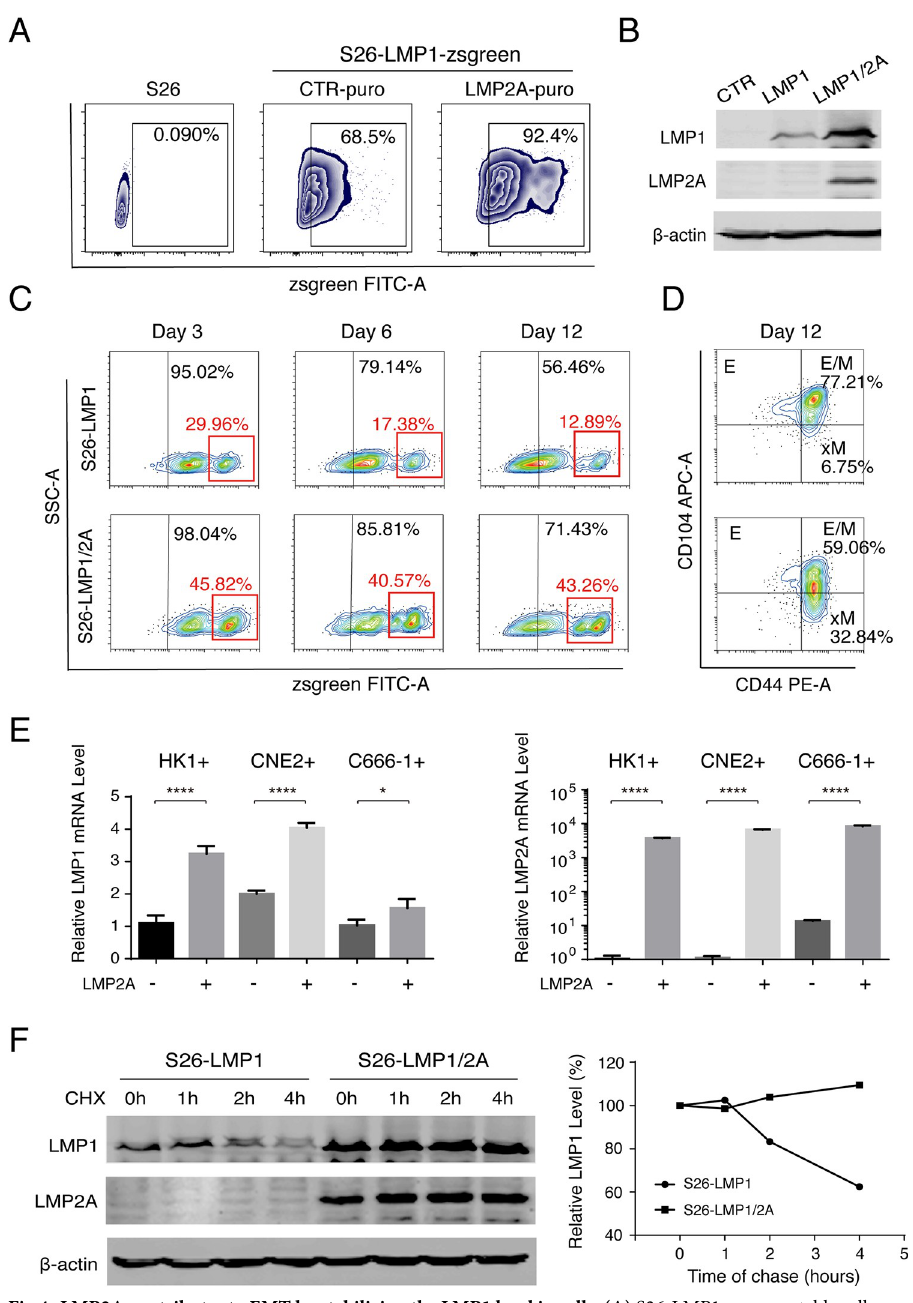
Fig 4. LMP2A contributes to EMT by stabilizing the LMP1 level in cells. (A) S26-LMP1-zsgreen stable cells were transduced with pLVX-EF1 α -LMP2A-N1-Puro (LMP2A-puro) or CTR-puro lentiviral vectors (CTR-puro) to establish the S26-LMP1 zsgreen /2A puro (S26-LMP1/2A) and its control cell lines (S26-LMP1). The population of LMP1 positive (zsgreen positive) was analyzed by flow cytometry analysis. ( B) The expression levels of LMP1 and LMP2A in S26-CTR, S26-LMP1 and S26-LMP1/2A cells were confirmed using Western analysis. ( C) The maintenance of LMP1 high population (zsgreen high ) in S26-LMP1 and S26-LMP1/2A cells over time after sorting (up to 12 days) was determined by flow cytometry. ( D) The CD44 and CD104 FACS profiles of S26-LMP1 and S26-LMP1/2A cells were analyzed on Day 12. ( E) Three EBV positive NPC cells (HK-1+, CNE2+, C666-1) were transduced with LMP2A expression lentiviral vectors or control (pLVX-EF1 α -LMP2A-N1-Puro or CTR-puro). Relative mRNA expression levels (relative to GAPDH) of LMP1 and LMP2A in these cells are shown. (Mean+/- SD of three biological replicates). (F ) S26-LMP1 cells and S26-LMP1/2A cells were treated with 100 μ M cycloheximide (CHX) for 0, 1, 2, 4 hours, and the LMP1 and LMP2A levels were analyzed using Western blot and plotted against time. The data are represented as percentages of the protein detected at the beginning of the incubation (0 hours), all protein signals have normalized to β -actin.